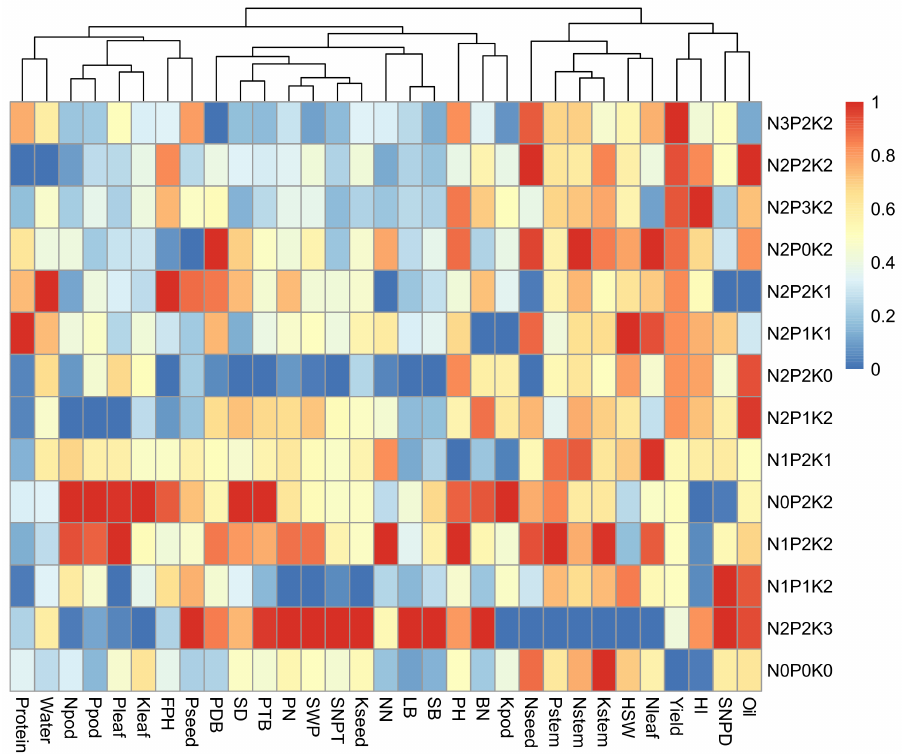
Figure 4. The heatmap of 31 traits for the 3414-experiment design. The color indicates the correlation between treatment and